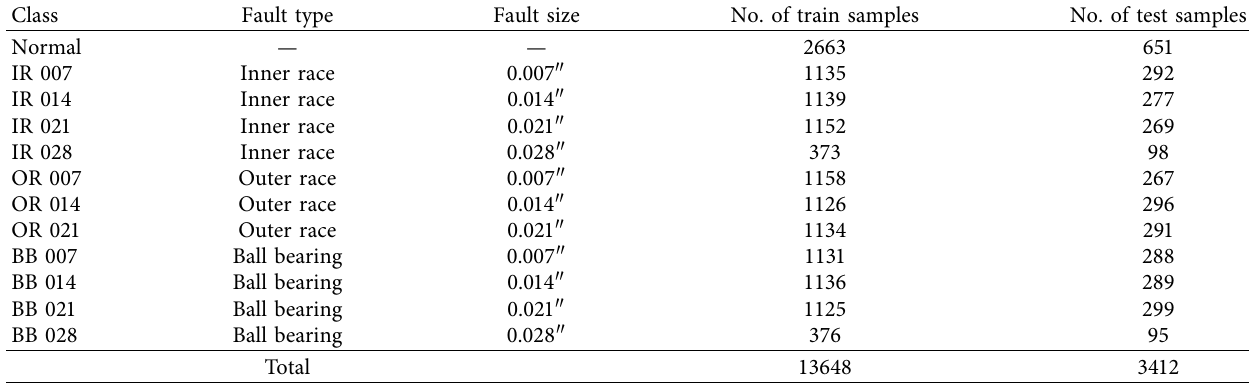
Table 4: Dataset B for fault severity